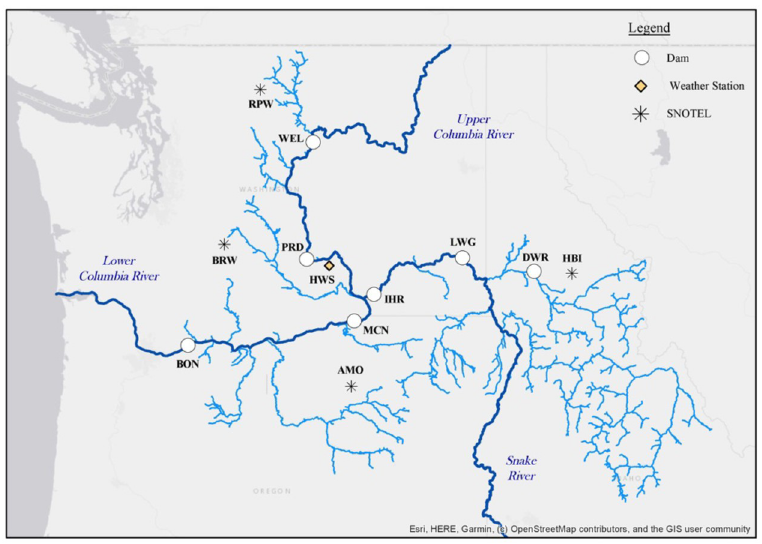
Fig 1. Map of Columbia River Basin with dams and observation sites marked. Abbreviations are listed in Table 1. Flow and temperature gage stations correspond with dam locations (white circles). SNOTEL sites correspond with snow-water-equivalent (SWE)